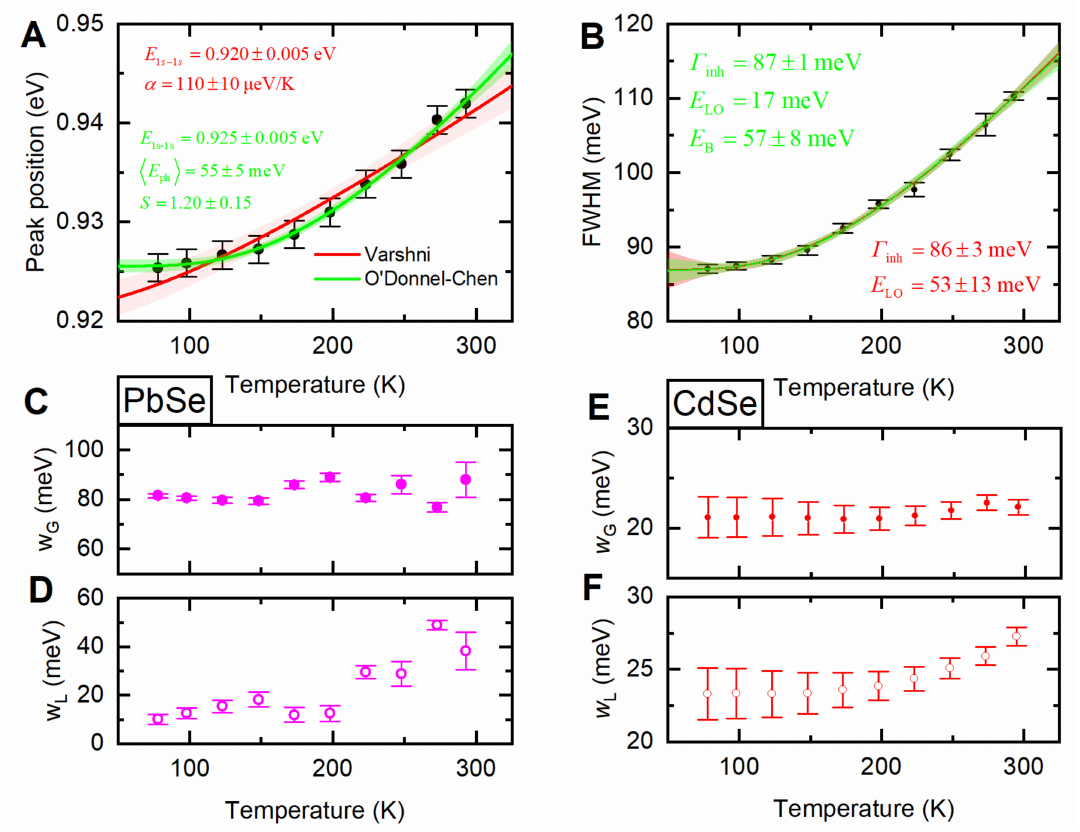
Figure 3. ( A ) PL1 peak position of four ML PbSe NPLs vs. temperature, the red line marks the Varshni fit, the green line marks the O’Donnel-Chen fit, and the semi-transparent areas mark the 95% confidence band; ( B ) PL1 full width at half maximum (FWHM) vs. temperature, lines show the FWHM fit with Equation (3) (red) and Equation (4) (green), and the semi-transparent areas mark the 95% confidence band; ( C , D ) PbSe (purple) and ( E , F ) CdSe (red) Gaussian (solid), and Lorentz (open) linewidths extracted from the Voight